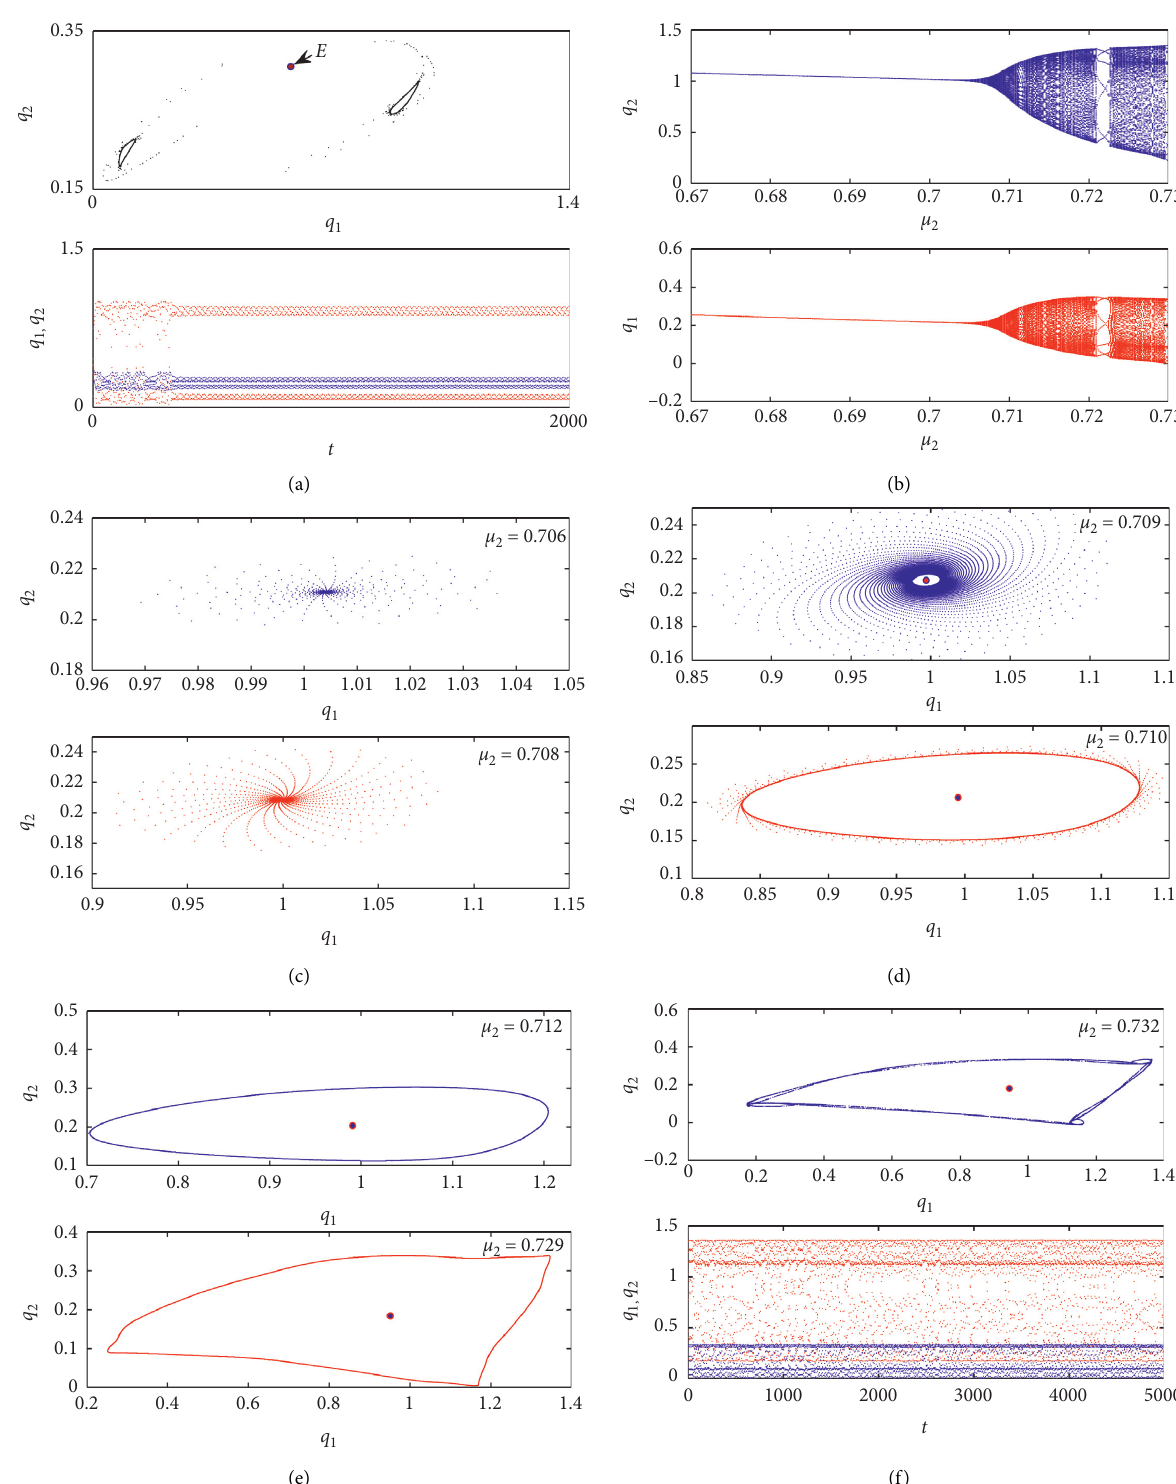
Figure 5: The fixed parameter values are ( q � 0 . 73. The time series of q μ 2 varying the parameter μ corresponding to the chaotic attractor are also